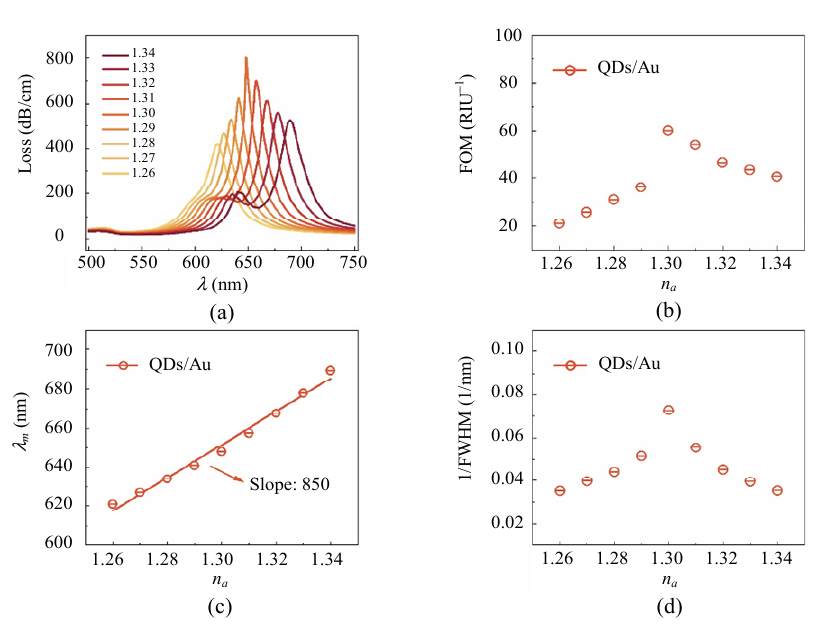
Fig. 6 Sensor performances for the central hole size equaling D –0.1 L for different n a : (a) the loss spectra, (b) FOM, (c) peak position and corresponding linear fit result, and (d)